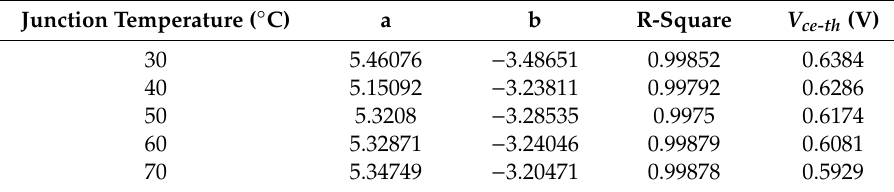
Table 1. V ce-th extraction at different junction temperatures.